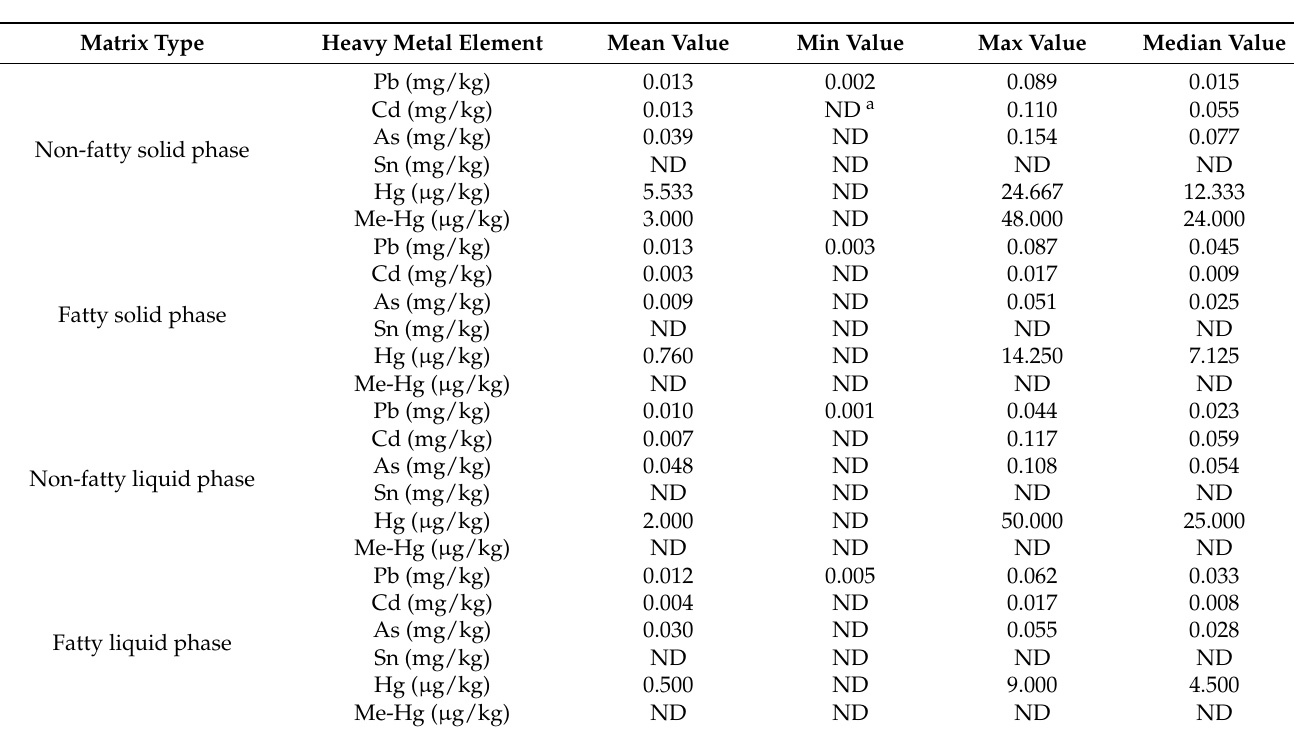
Table 5. Heavy metal concentrations in non-fatty solid phase, fatty solid phase, non-fatty liquid phase and fatty liquid phases of